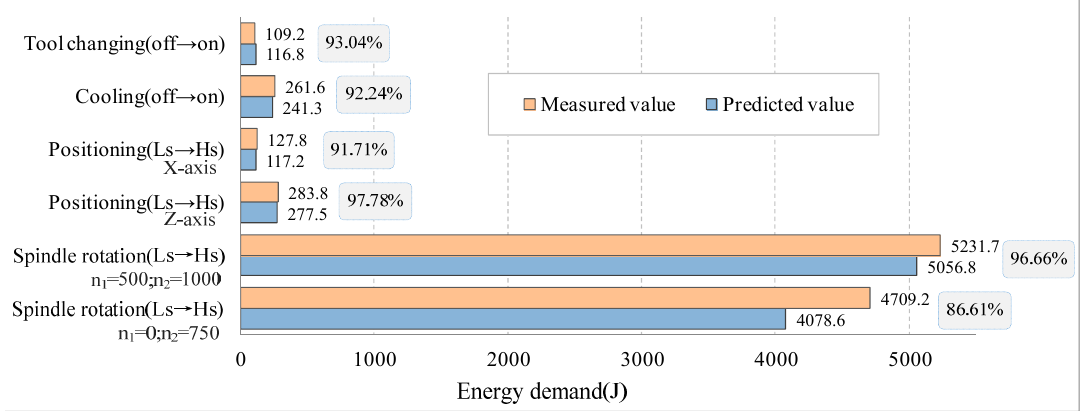
Figure 14. Predicted energy values vs. measured values of state transitions.